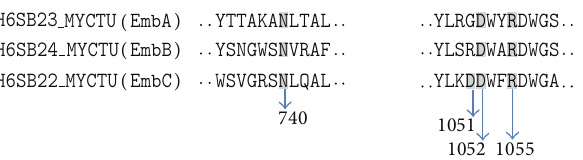
Figure 2: Preliminary sequence comparison of the C-terminal domain in EmbC with the same region in EmbB and EmbA using ClustalW.